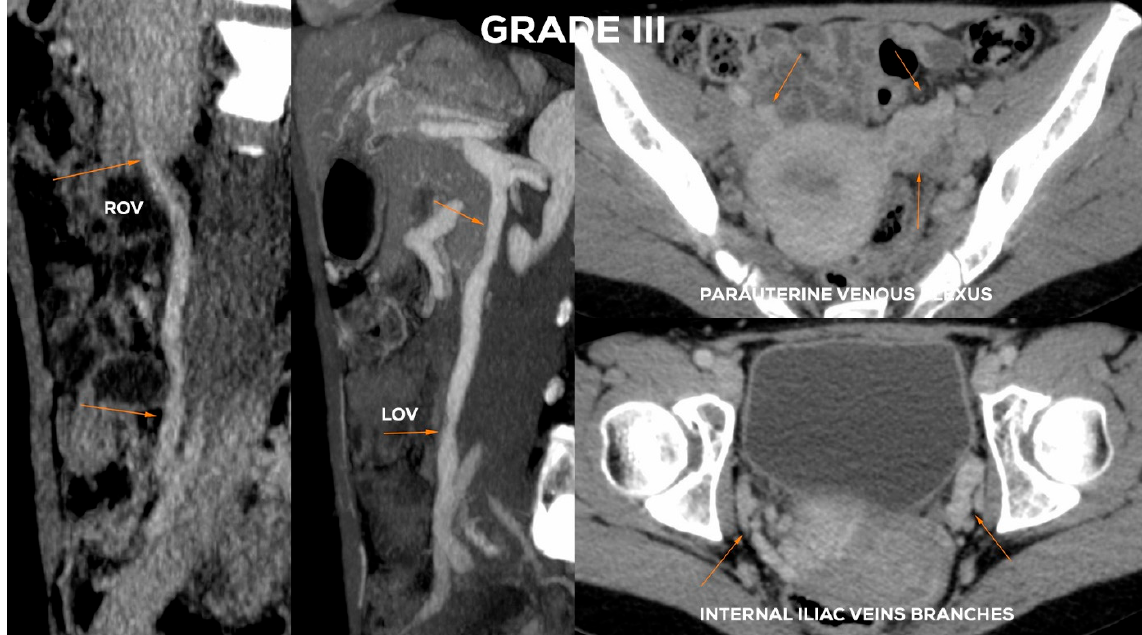
Figure 15. Typical findings in patient with Grade III ovarian veins insufficiency seen on CTV images in sagittal and axial planes.